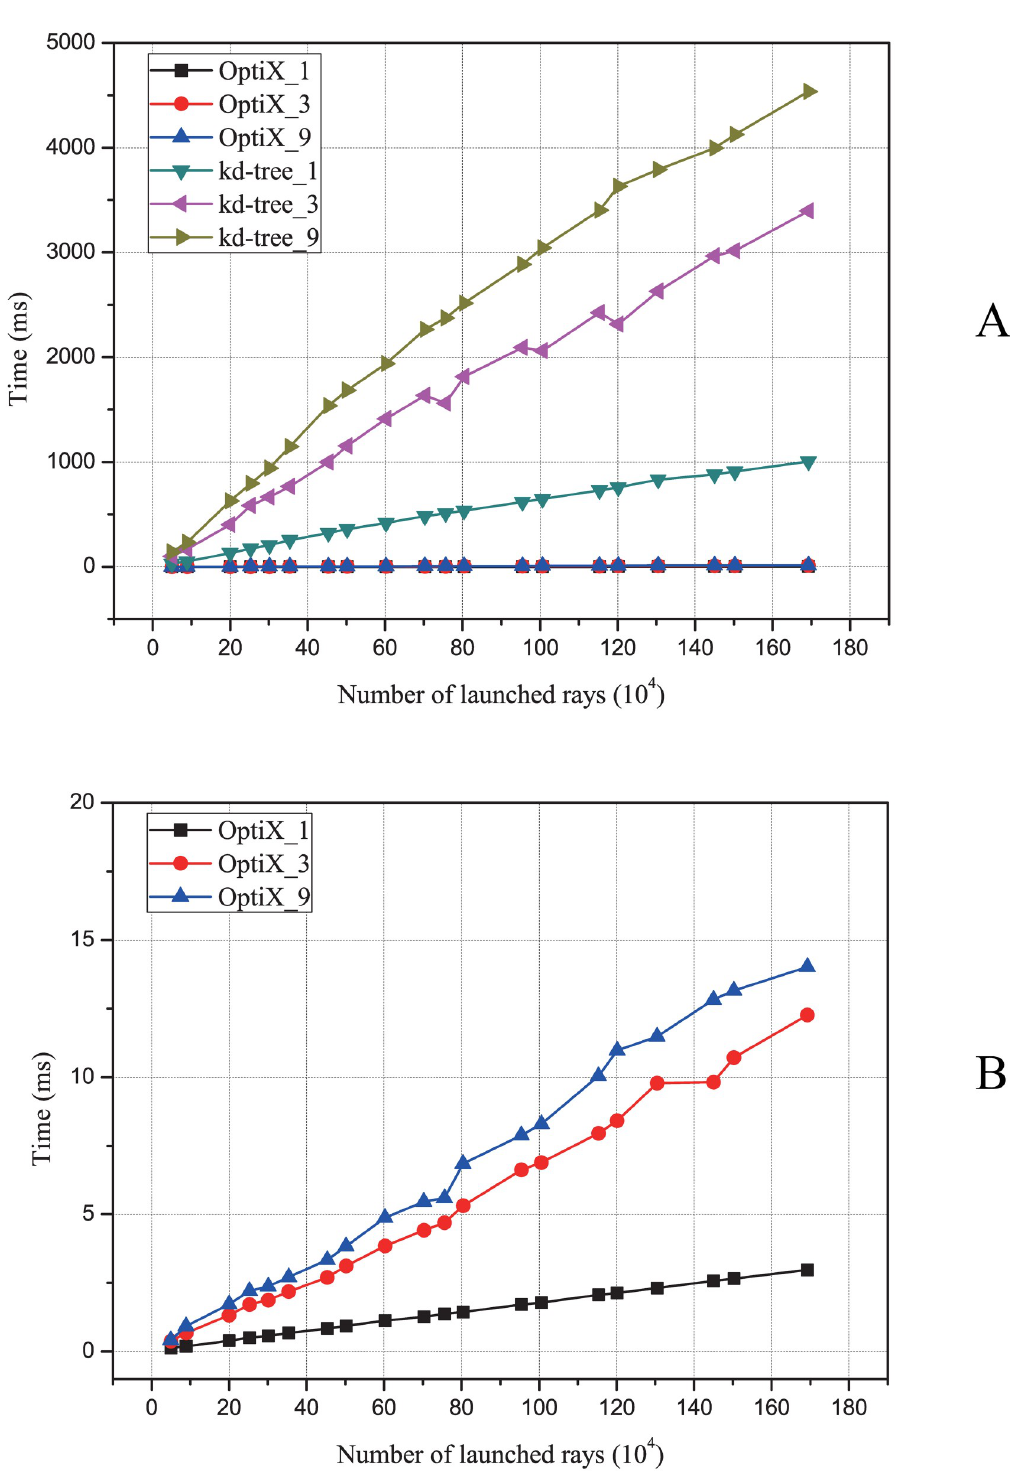
Fig 6. The ray tracing performance of different algorithms. (Panel A), the relationship between the simulation time and the number of rays under different number of reflections for the ray tracing method based on kd-tree and the ray tracing method based on OptiX. (Panel B) the performance of the OptiX-based method under different number of reflections.